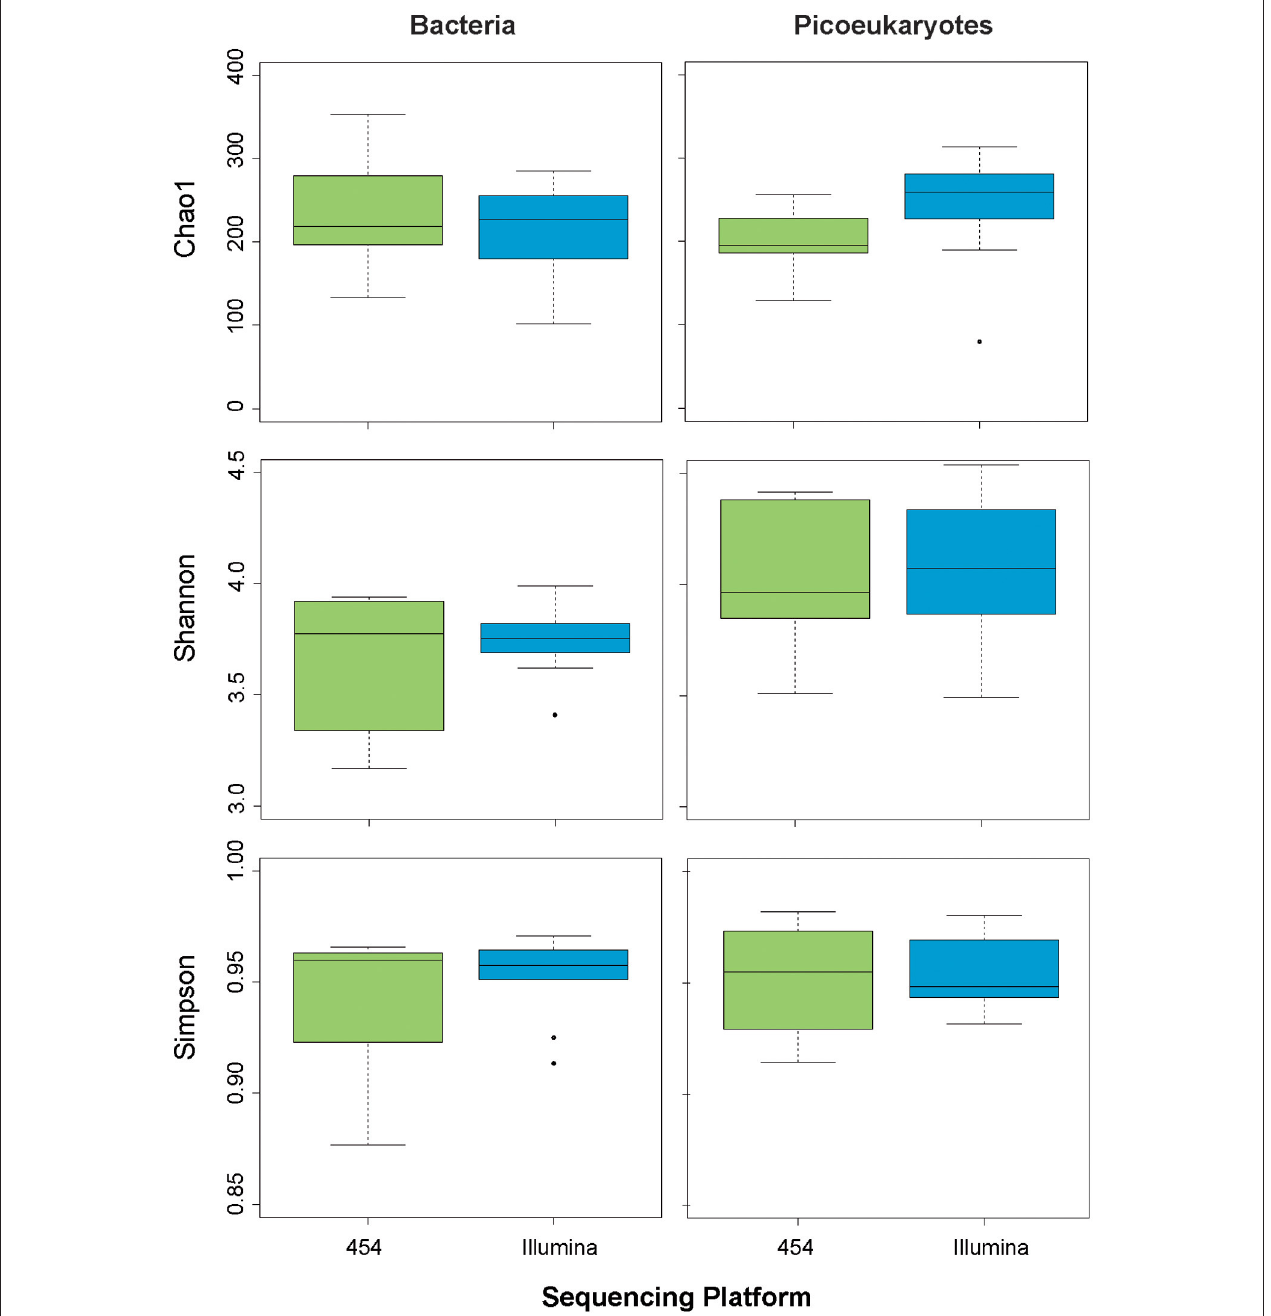
FIGURE 4 | Box plots showing various estimates of alphadiversity (Chao1, Simpson, Shannon) depending on sequencing methodology for bacteria (left panels) and picoeukaryotes (right panels).